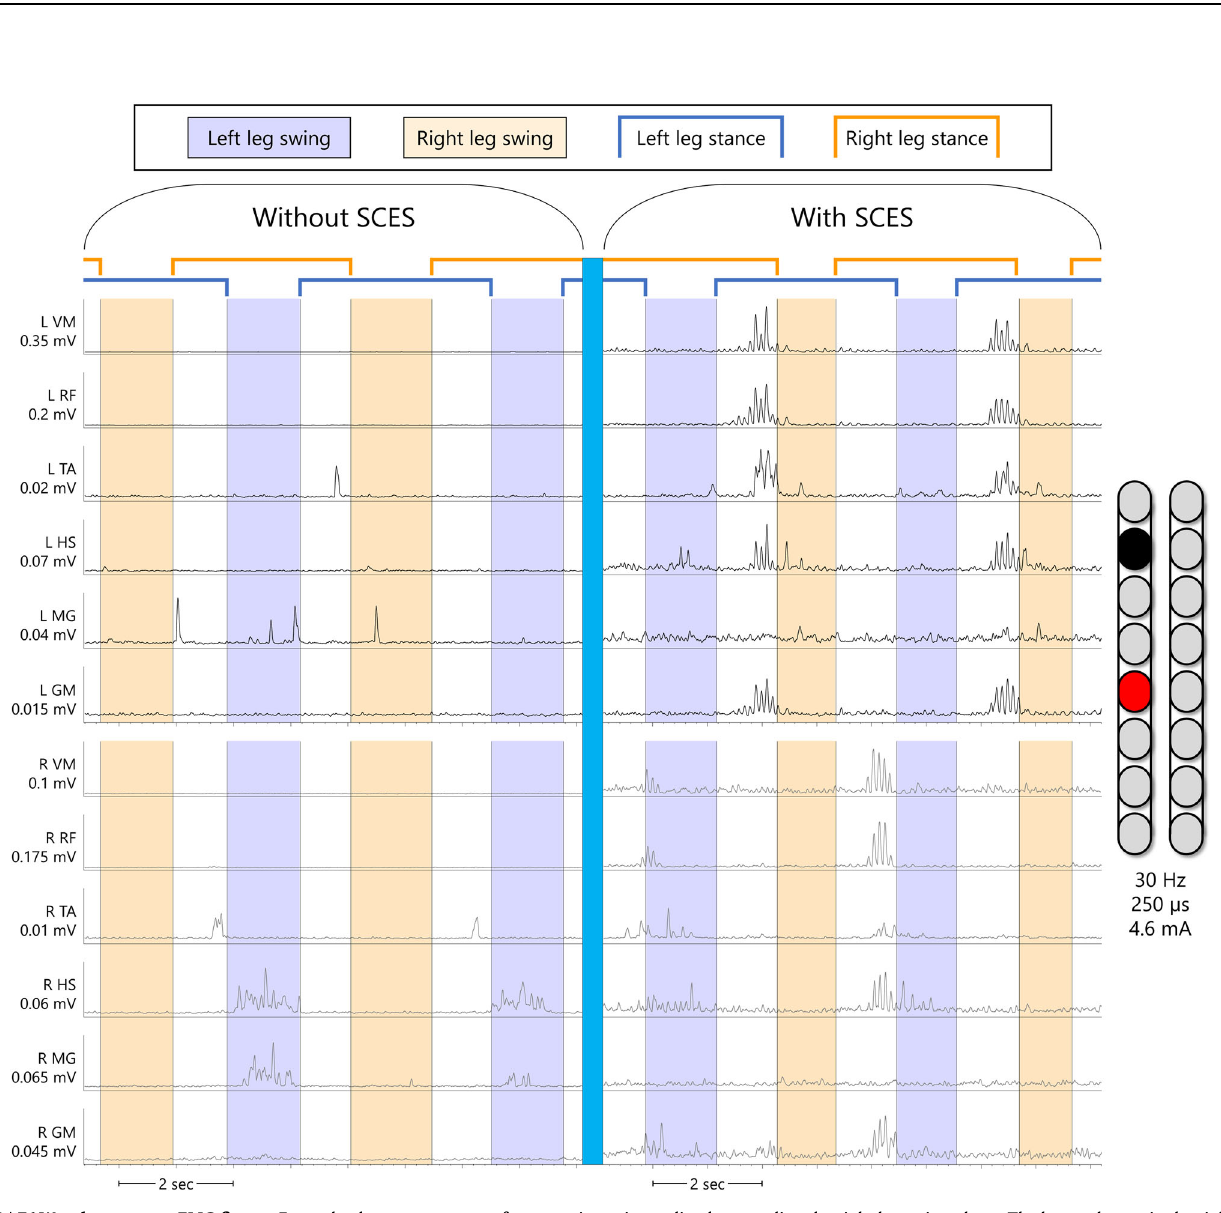
immediatelyprecedingtherightlegswingphase.Thelargestburstsintherightleg muscles occur in a similarfashion, inthat thebursts occur simultaneouslythrough all right leg muscles immediately preceding or slightly overlapping with the beginning of the left leg swing phase. EMGs presented are band-pass fi ltered